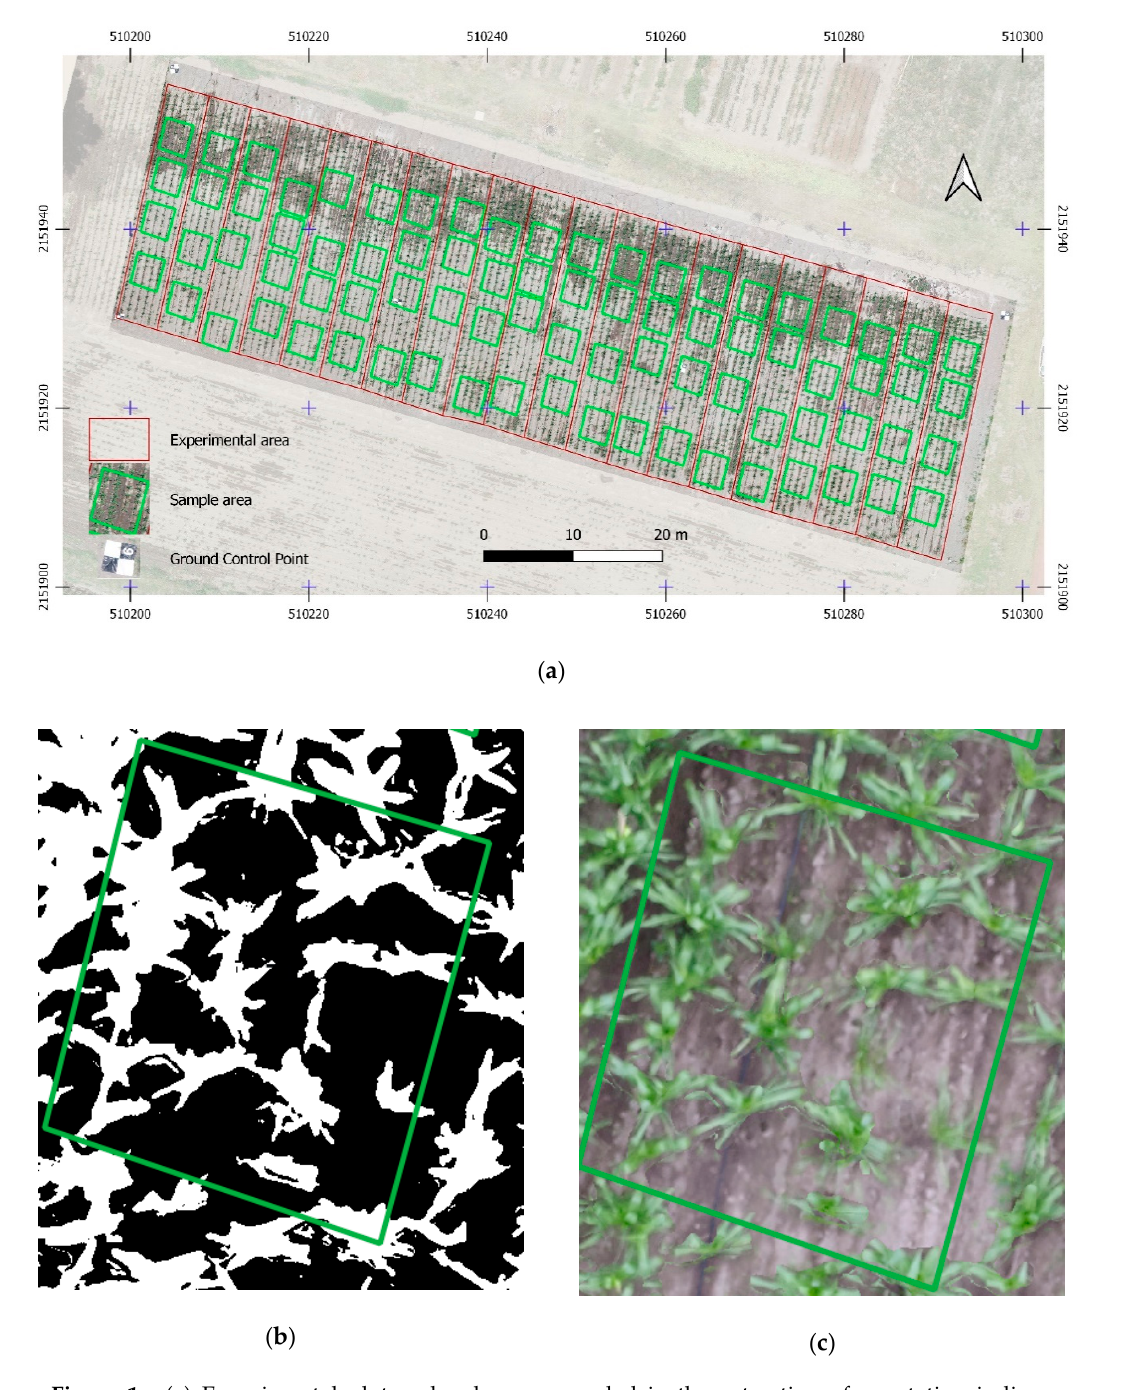
Figure 1. ( a ) Experimental plot and polygons sampled in the extraction of vegetation indices, canopy cover, and plant density; ( b ) binary image resulting from the classification of vegetation and soil; ( c ) polygon selected for the sampling of the canopy cover and plant density. Six vegetation indices were estimated based on the generated orthomosaics. Three vegetation indices based on the reflectance of the visible spectrum (RGB): TGI (triangular greenness index), EXG (green extraction index), and VARI (visible atmospherically resistant index), according to Table 2, and three multispectral indices based on the reflectance in the near infrared, the red, and the red edge bands: NDVI (normalized difference vegetation index), NDRE (green extraction index), and WDRVI